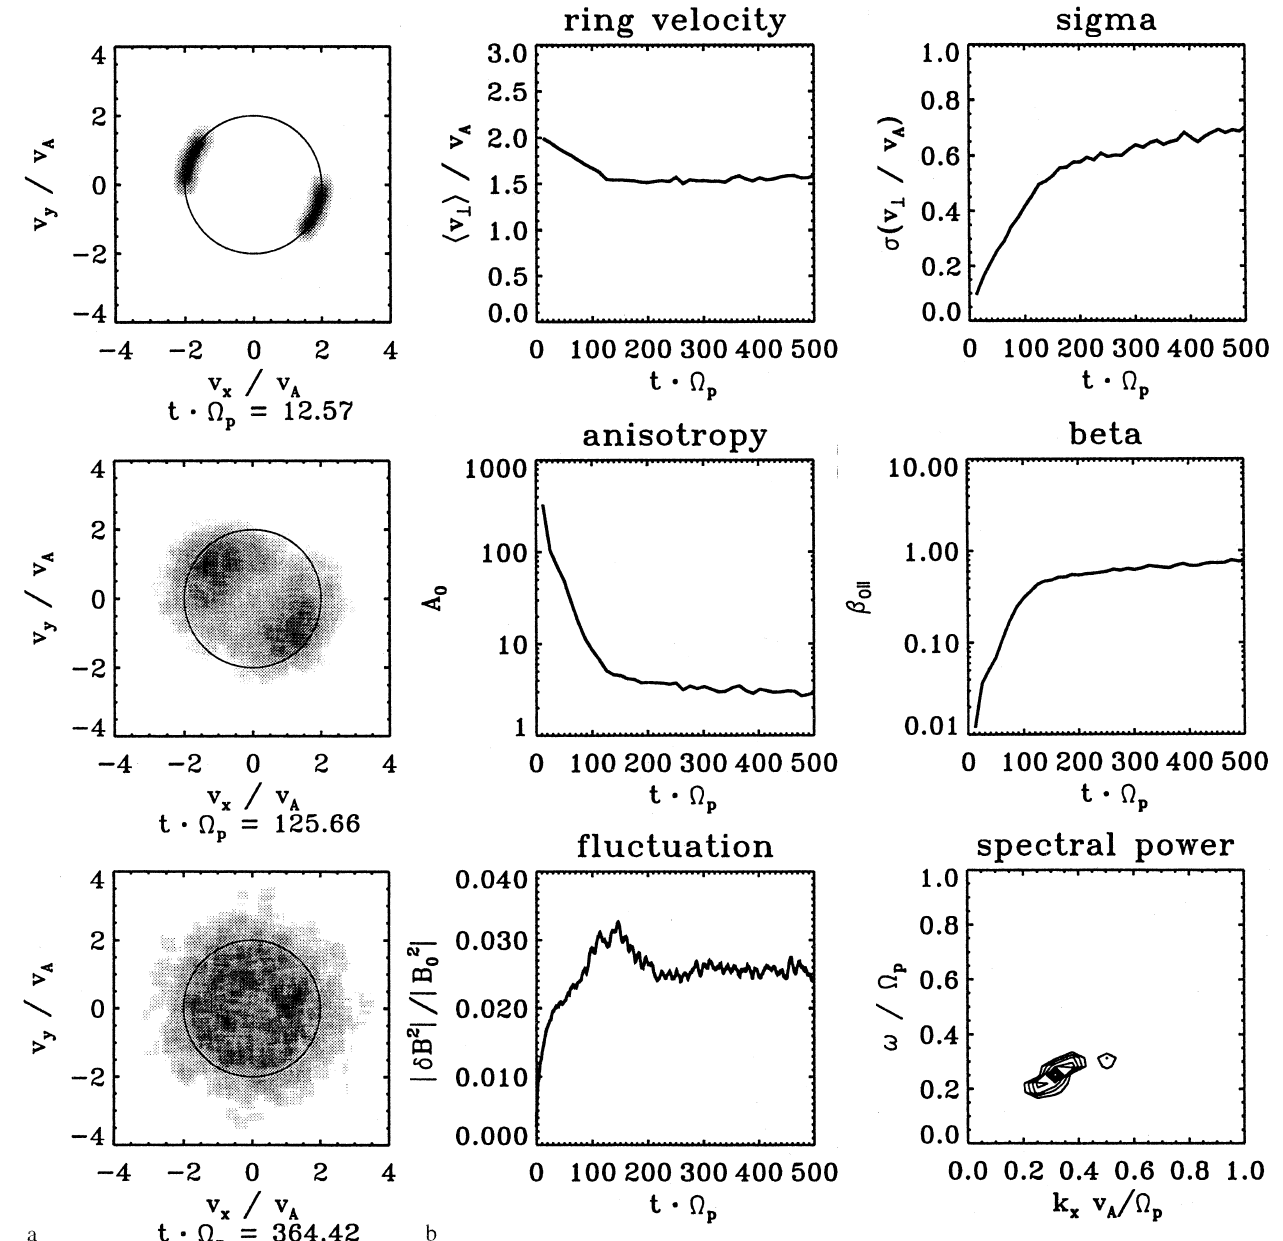
and the magnetic fluctuations; the panel bottom right represents a contour plot of the magnetic spectral density in the saturation phase (cid:133) t (cid:88) p (cid:136) (cid:137) 125 ... 325